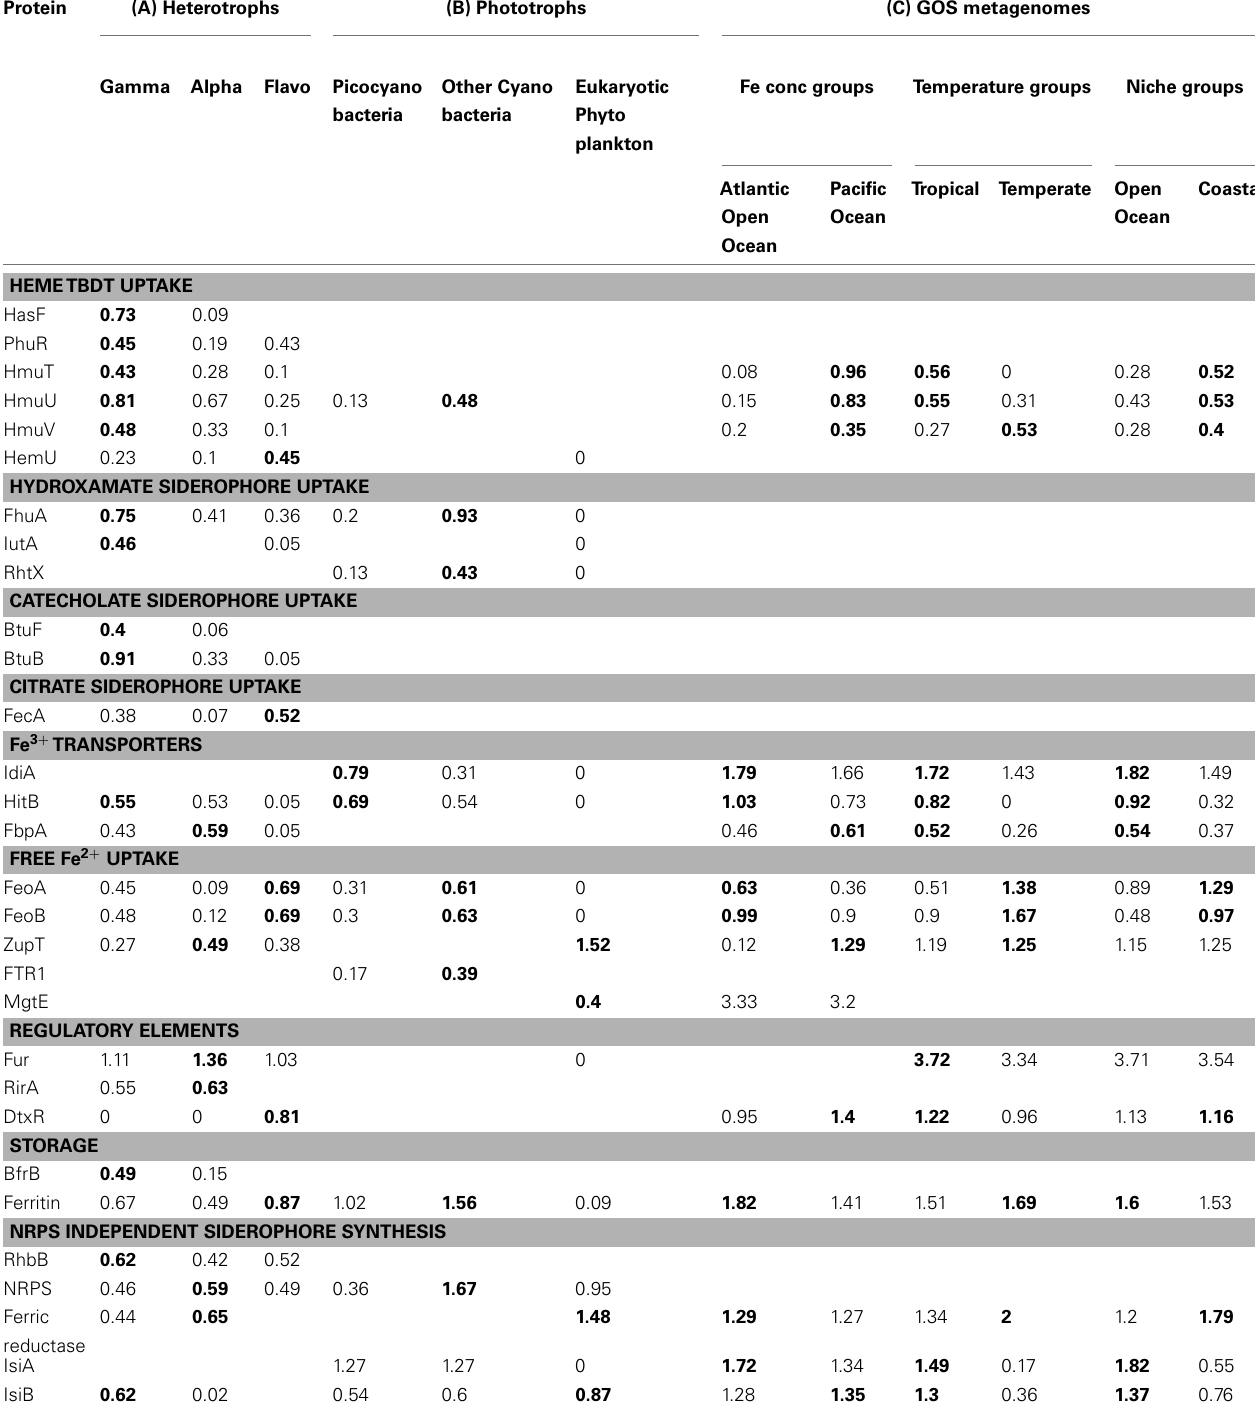
Table 3 | Fe-metabolism protein components discriminating between the three major taxonomic groups of heterotrophs (A) and phototrophs (B) and groupings of the GOS metagenomes (C) identified using the Similarity Percentages (SIMPER) method.